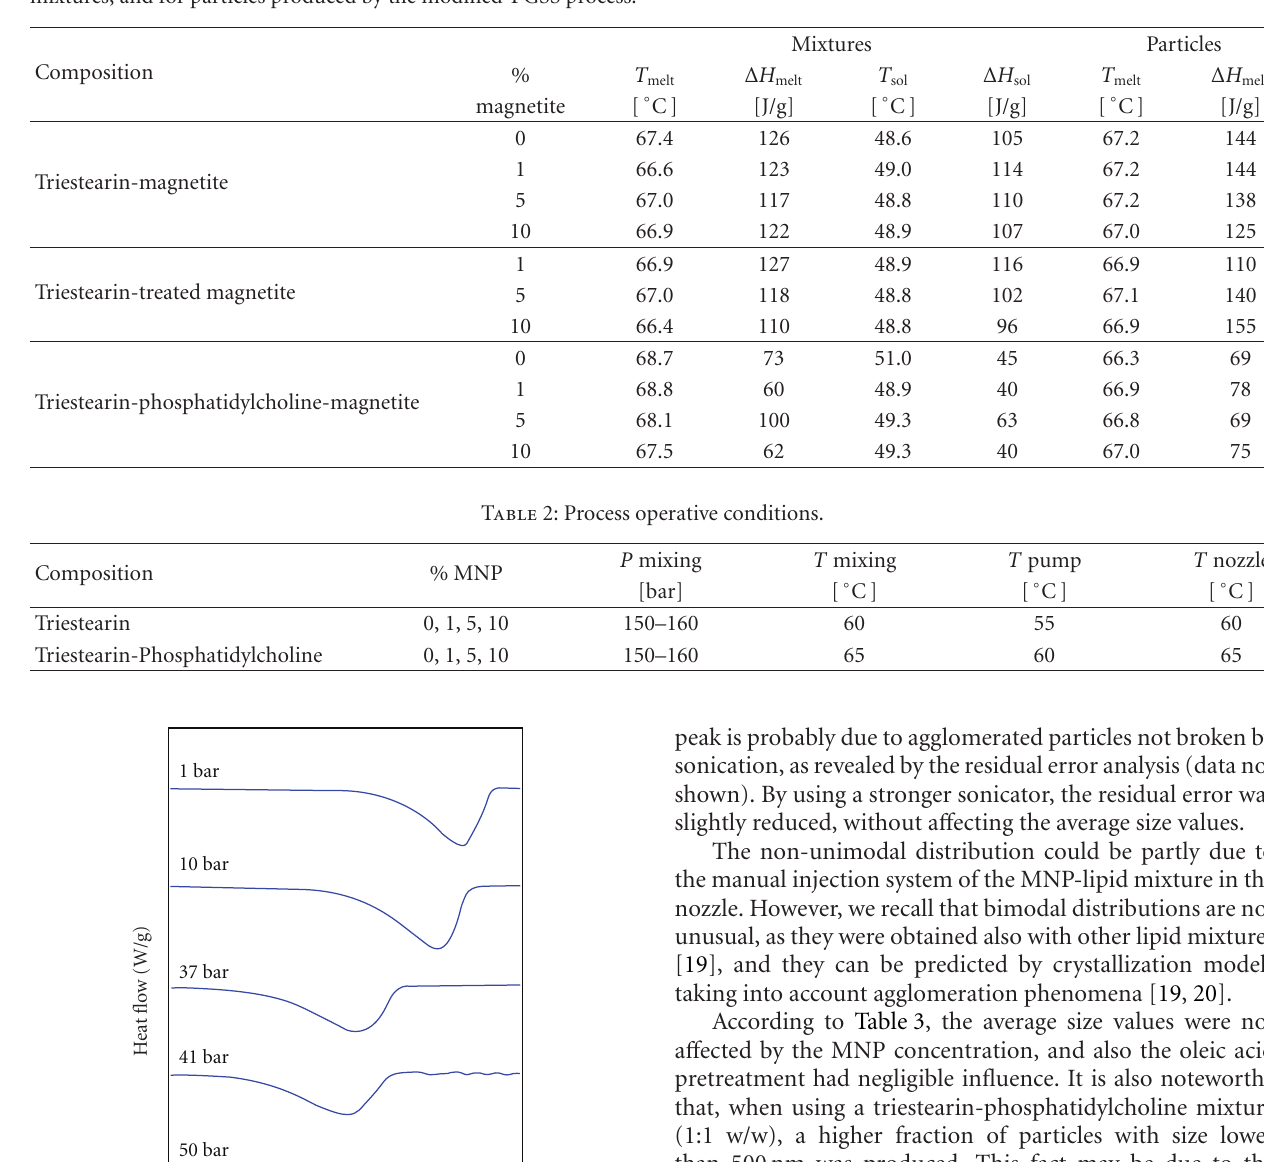
Table 1: DSC spectra measured at ambient pressure for triestearin-magnetite and triestearin-phosphatidylcholine-magnetite starting mixtures, and for particles produced by the modified-PGSS process.